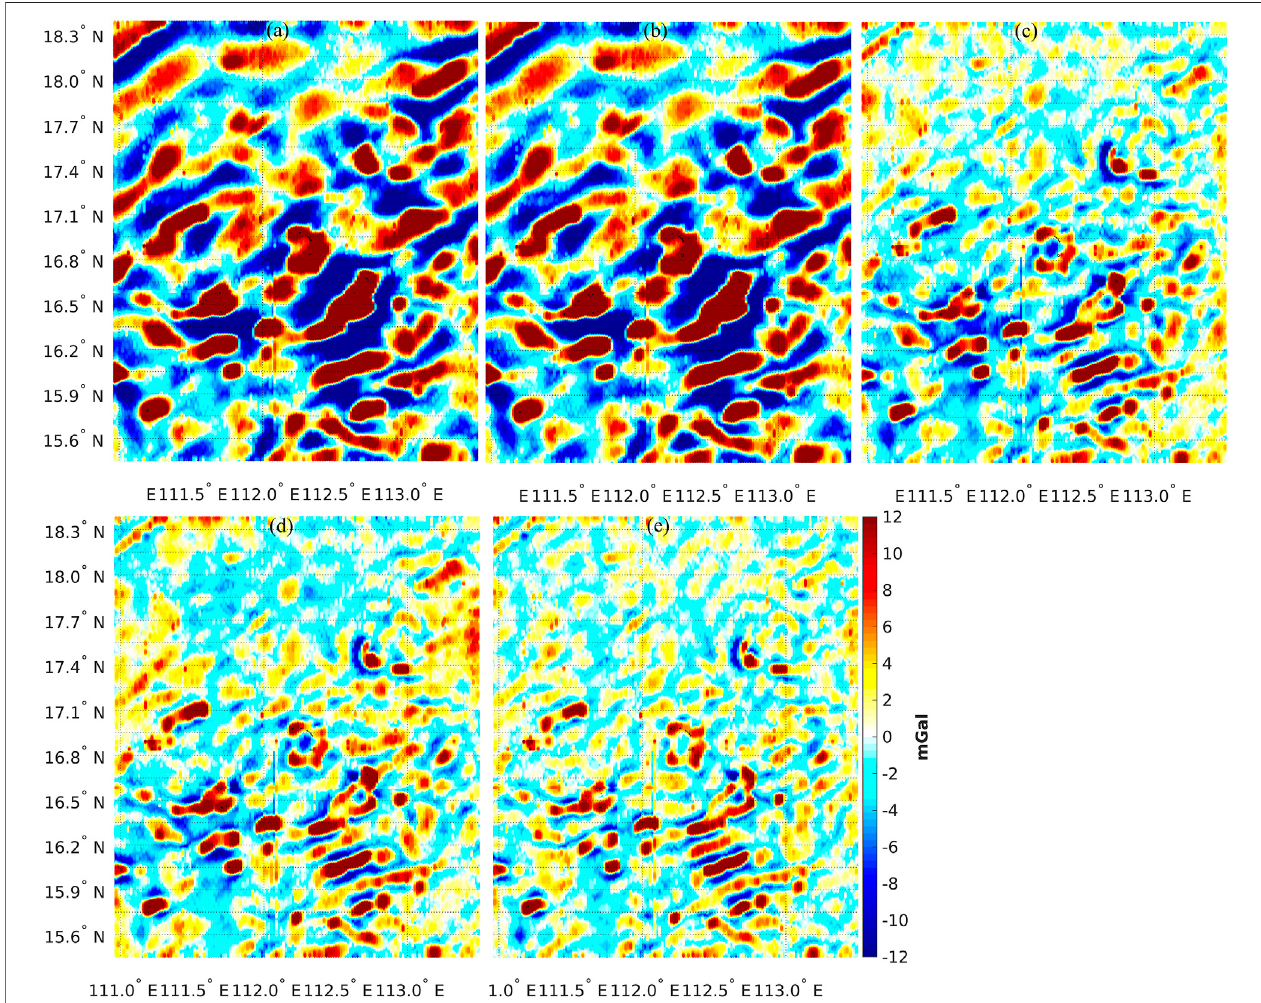
FIGURE 4 | Differences between the airborne gravity disturbances and quantities synthesized from (A) GOCO05c (d/o 720), (B) XGM2019 (d/o 760), (C) EGM2008 (d/o 2190), (D) EIGEN-6C4 (d/o 2190), and (E) XGM2019e_2159 (d/o 2190) over Paracel Islands.